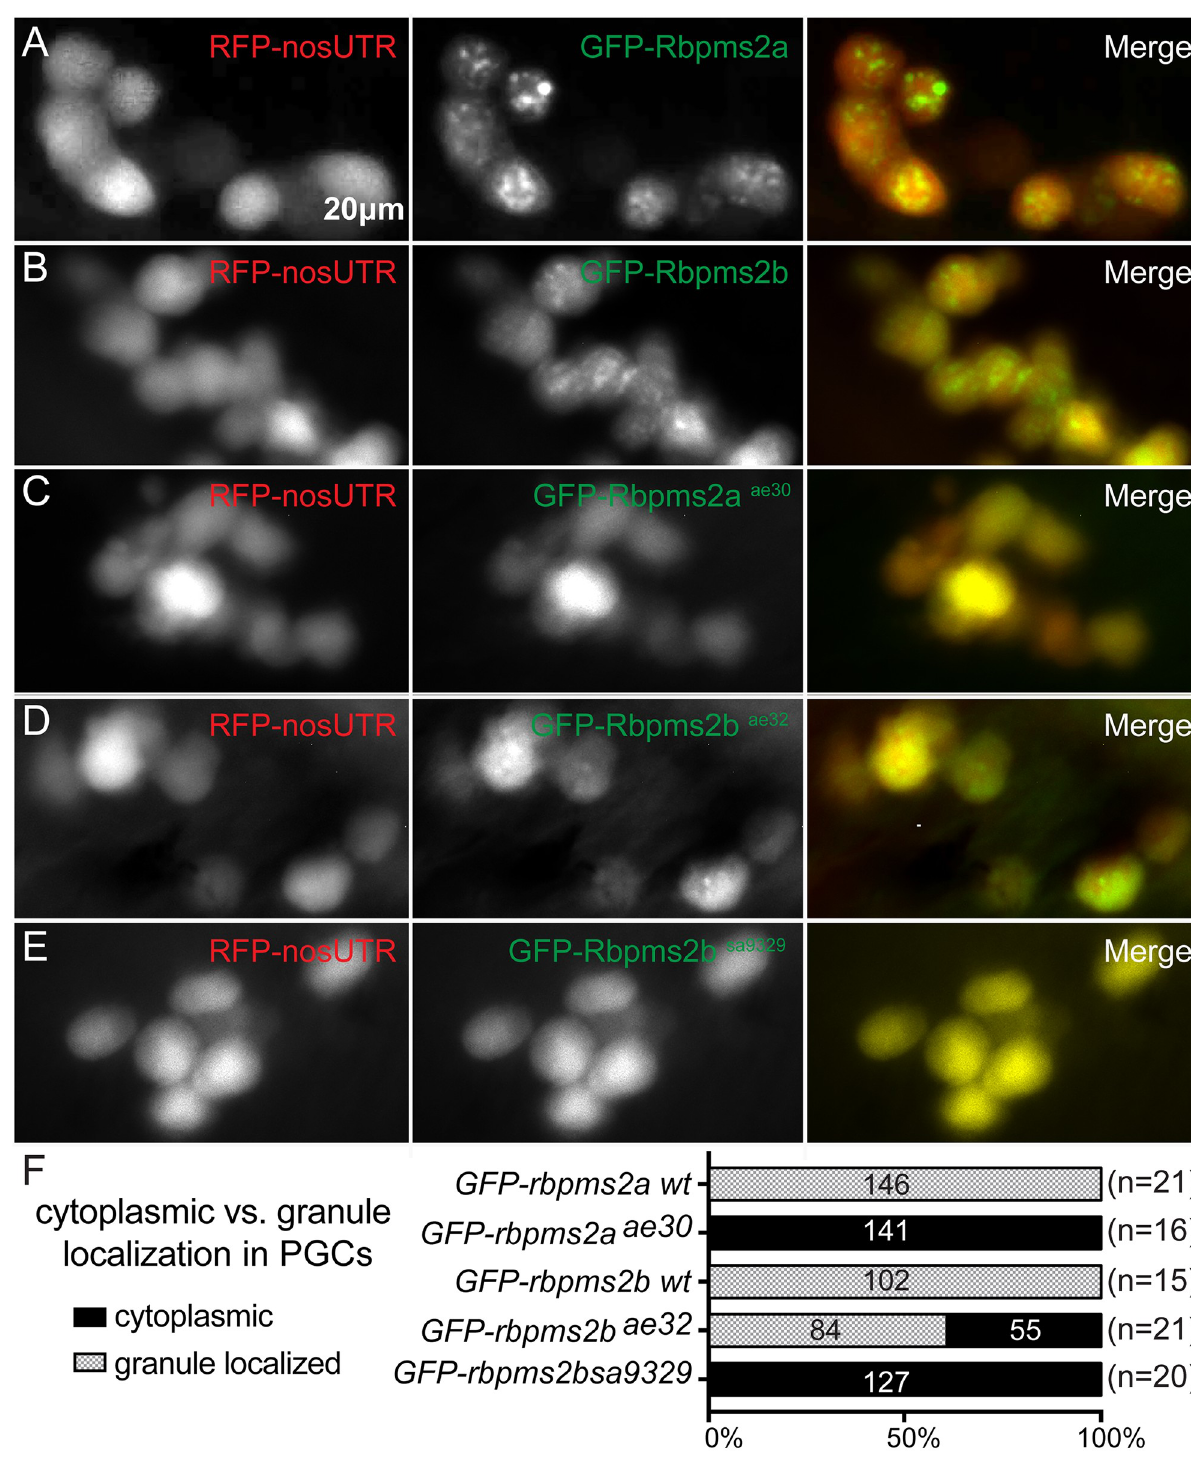
Fig 5. rbpms2 mutant allele stability and localization activity in germ cells. (A-B) Wild-type GFP-Rbpms2a/b localize to germ granules of PGCs. PGCs are labeled with RFP- nos3’utr at 30hpf. (C-E) Like wild-type Rbpms2a and Rbpms2b, GFP-Rbpms2a ae30 (C), GFP-Rbpms2b sa9329 (D), and GFP-Rbpms2b ae32 (E) are all enriched in germ cells. However, GFP-Rbpms2a ae30 and GFP-Rbpms2b sa9329 are not localized to granules; whereas, GFP-Rbpms2b ae32 is partially localized to germ granules. (F) Graph depicting percentage of granule vs. cytoplasmic localization of GFP-rbpms2